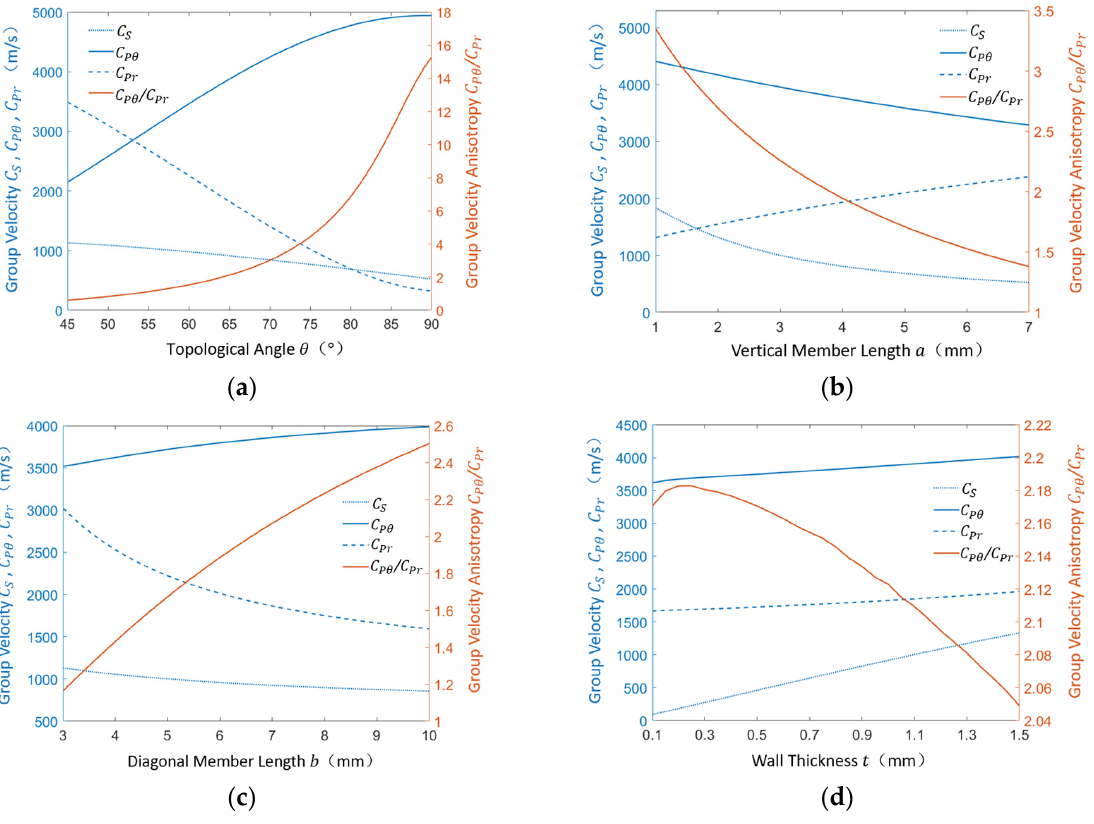
Figure 10. Effects of cellular structure parameters on group velocity anisotropy. ( a ) Effect of topo- logical angle 𝜃 ; ( b ) effect of vertical member length 𝑎 ; ( c ) effect of diagonal member length 𝑏 ; and ( d ) effect of wall thickness 𝑡 .